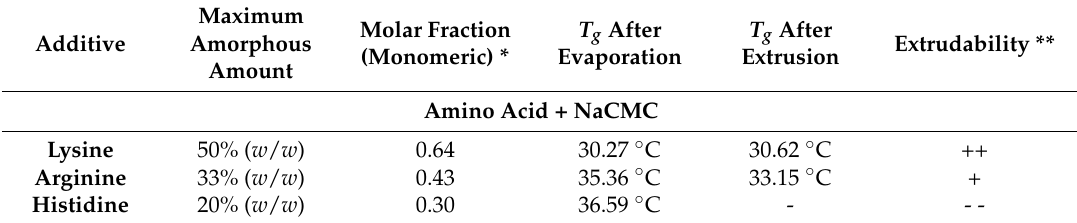
Table 1. Properties of amino acid / polyelectrolyte matrices.